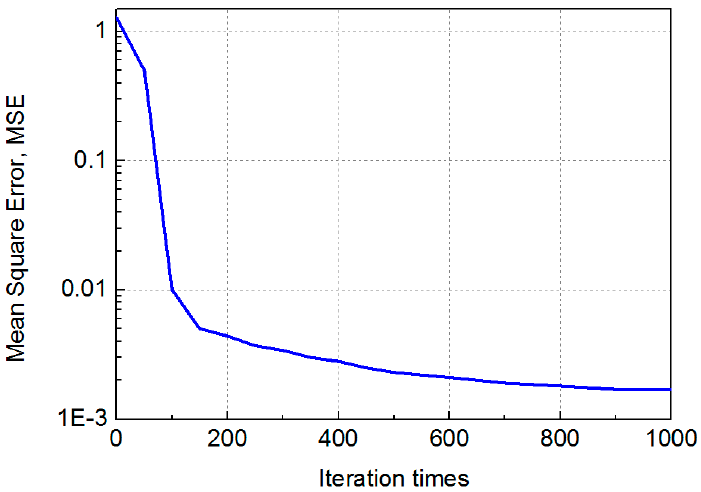
Figure 16. MSE performance with the arbitrary training data set. Table 5. Time cost of different algorithms with arbitrary training data set.